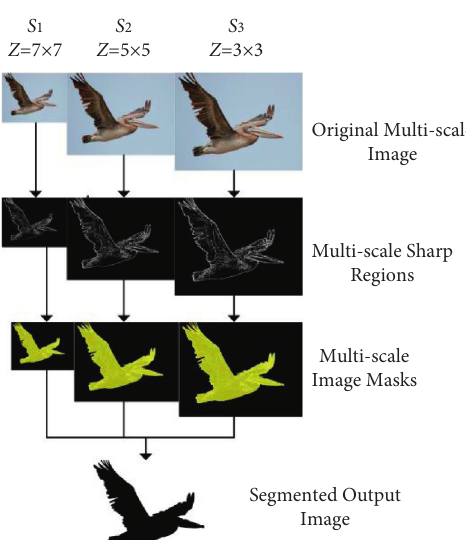
Figure 4: Multiscale image masking and Otsu